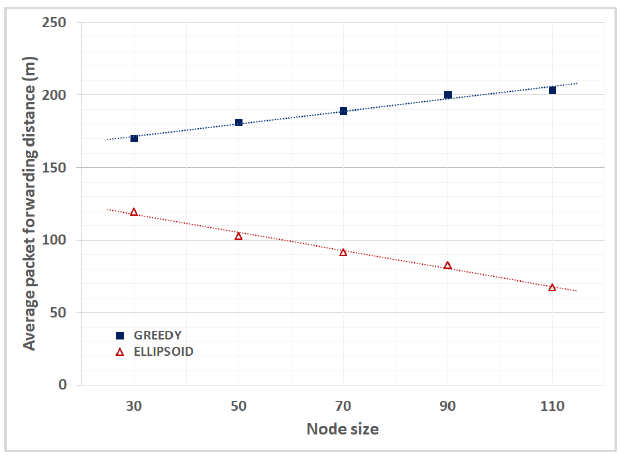
Figure 2. Packet forwarding distance averages with trendlines (VANET